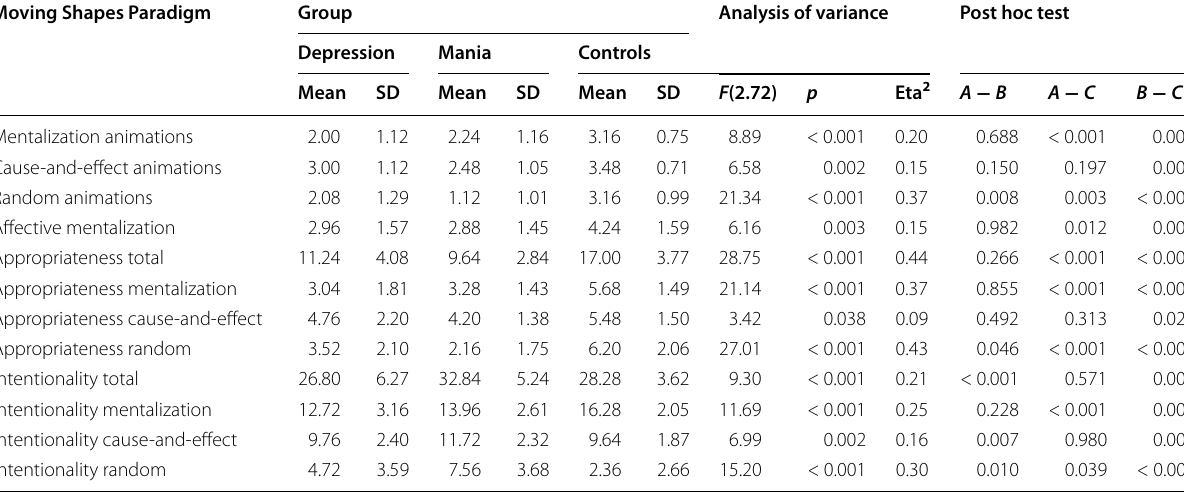
Table 2 The results of mentalization assessed by the Moving Shapes Paradigm during depression ( A ), mania ( B ) and in healthy control subjects ( C ) Moving Shapes Paradigm